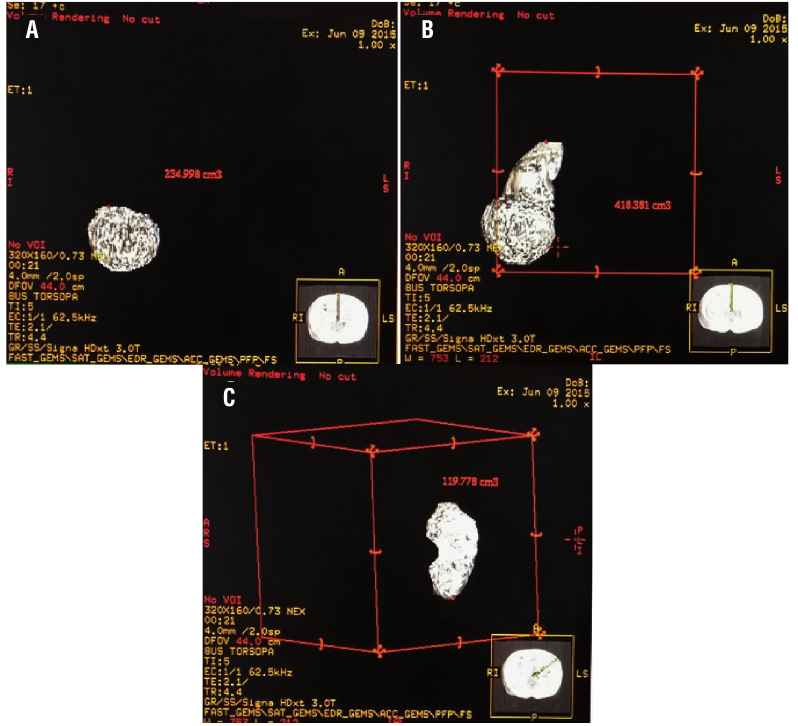
unaffected kidney volume, in a patient planned for radical